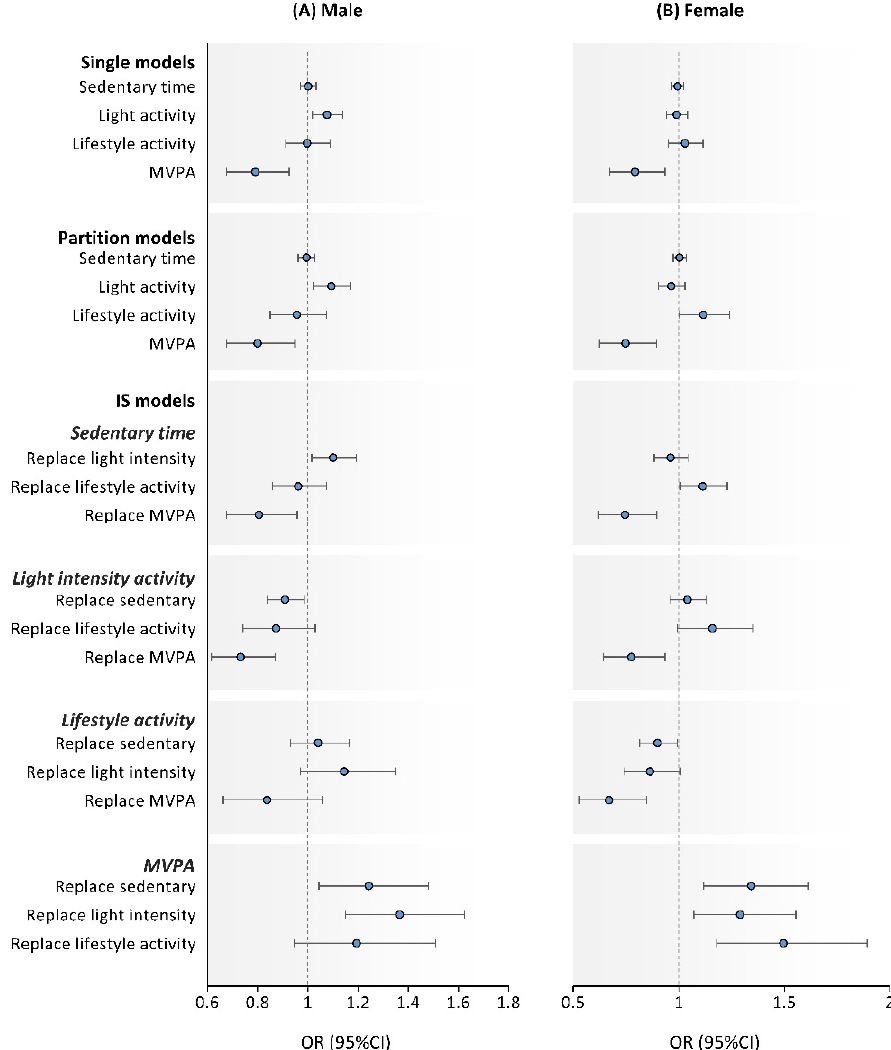
Figure 2. Single factor, partition, and isotemporal substitution models examining the association of sedentary behavior, light and lifestyle, and MVPA with adverse cardiometabolic health ( ≥ 4 risk factors) by male ( A ) and female ( B ). Note: Values were odds ratio (95%CI); each models including variables used models in Tables 3 and 4. MVPA, moderate-to-vigorous physical activity; OR, odds ratio; CI, confidence interval; IS model, isotemporal substitution model.